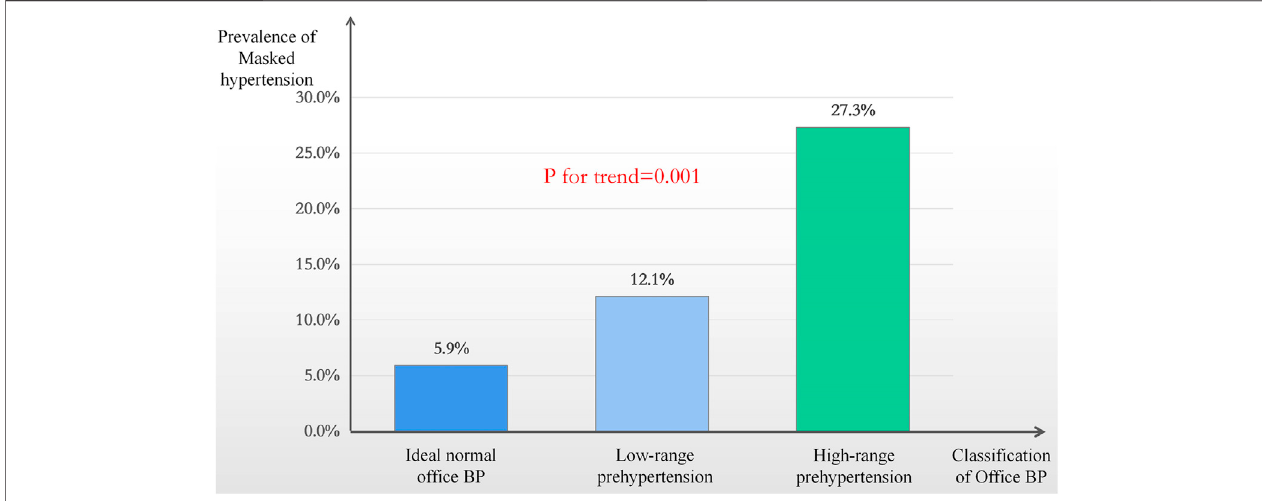
FIGURE 2 | The prevalence of masked hypertension in different of fi ce blood pressure distribution. BP = Blood pressure.